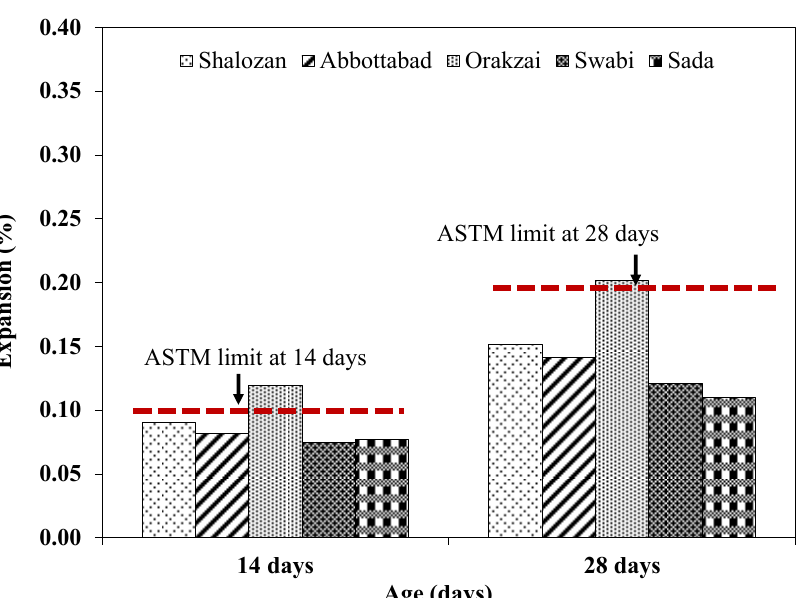
Figure 14. ASTM C1260 limits for the tested aggregates.